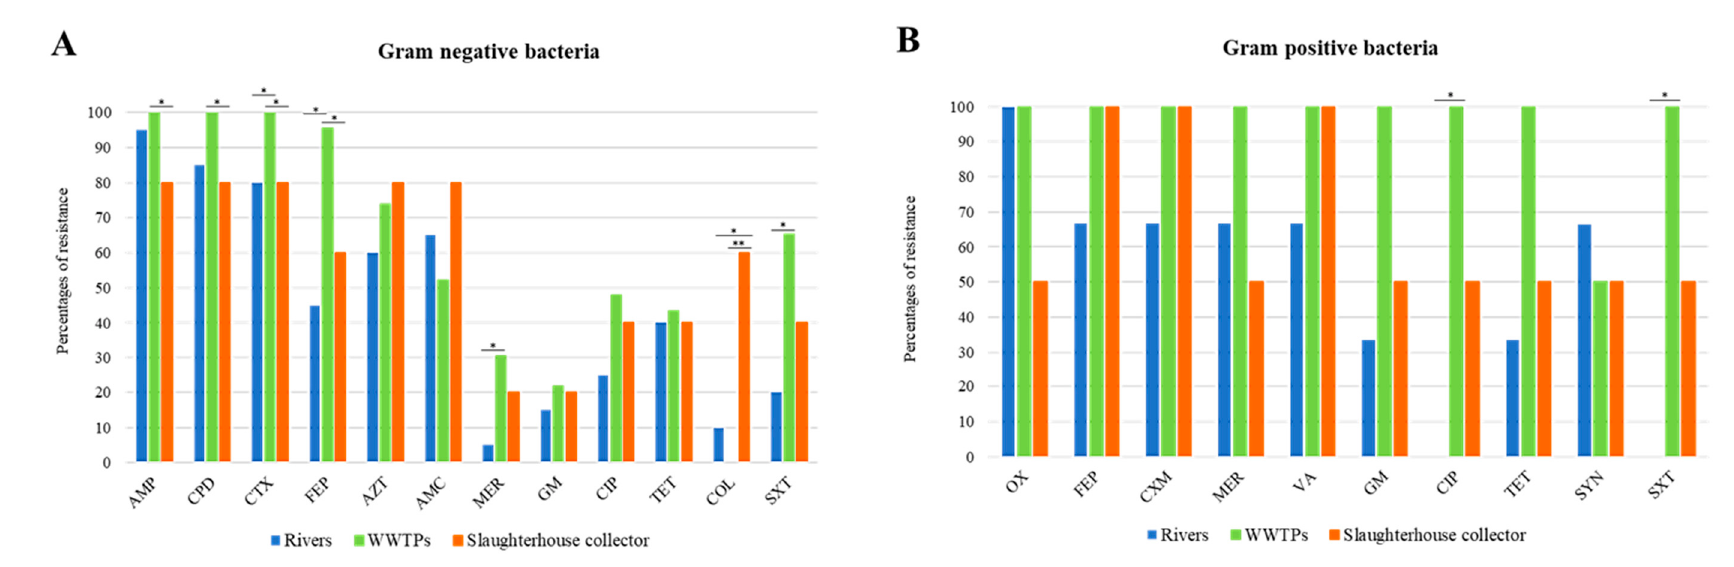
Figure 5. Resistance rate to each antibiotic according to the isolates origin. ( A ) Gram negative strains and ( B ) Gram positive strains. AMP (ampicillin); CPD (cefpodoxime); CTX (cefotaxime); FEP (cefepime); AZT (aztreonam); AMC (amoxicillin-clavulanic acid); MER (meropenem); GM (gentamicin); CIP (ciprofloxacin); TET (tetracycline); COL (colistin); SXT (trimethoprim-sulfamethoxazole); OX (oxacilin); CXM (cefuroxime); VA (vancomycin); SYN (synercid). (*, p < 0.05, **, p < 0.01) .